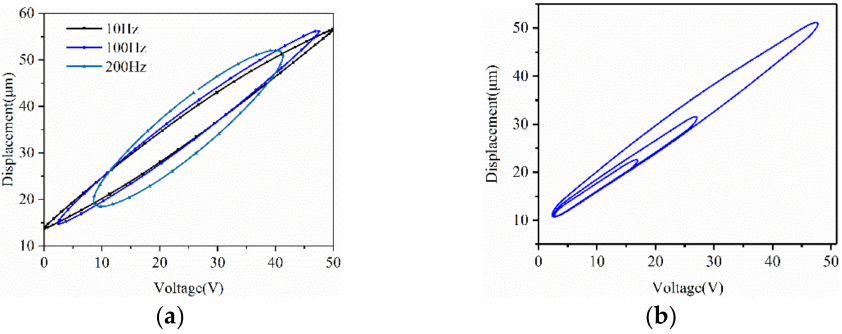
Figure 4. ( a ) Influence of the frequency of u ( t ) on the hysteresis, ( b ) Multi-hysteresis loops under